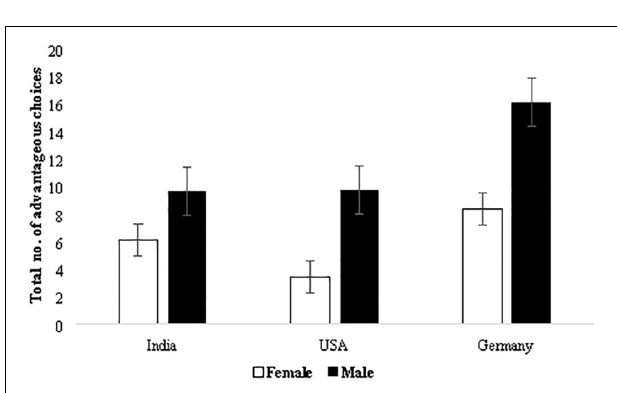
FIGURE 2 | Country and sex-specific comparison of advantageous decision making in 100 trials of the IGT. Error bars represent standard error.